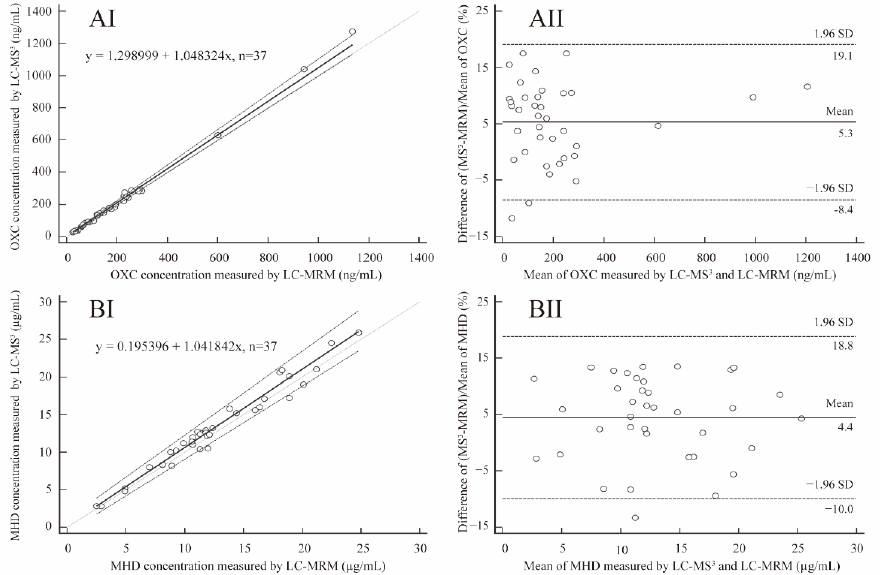
Figure 5. Comparison of the LC-MS 3 assay and LC-MRM method. ( I ) Passing–Bablok plots for the correlation analysis between LC-MS 3 and LC-MRM concentrations for oxcarbazepine ( AI ) and 10- hydroxycarbazepine ( BI ). Solid black lines represent Passing–Bablok regression. ( II ) Bland–Altman plot for the comparison between LC-MS 3 and LC-MRM concentrations for oxcarbazepine ( AII ) and 10-hydroxycarbazepine ( BII ). Points between the dashed lines indicate sample pairs that are within the ± 1.96 SD acceptance